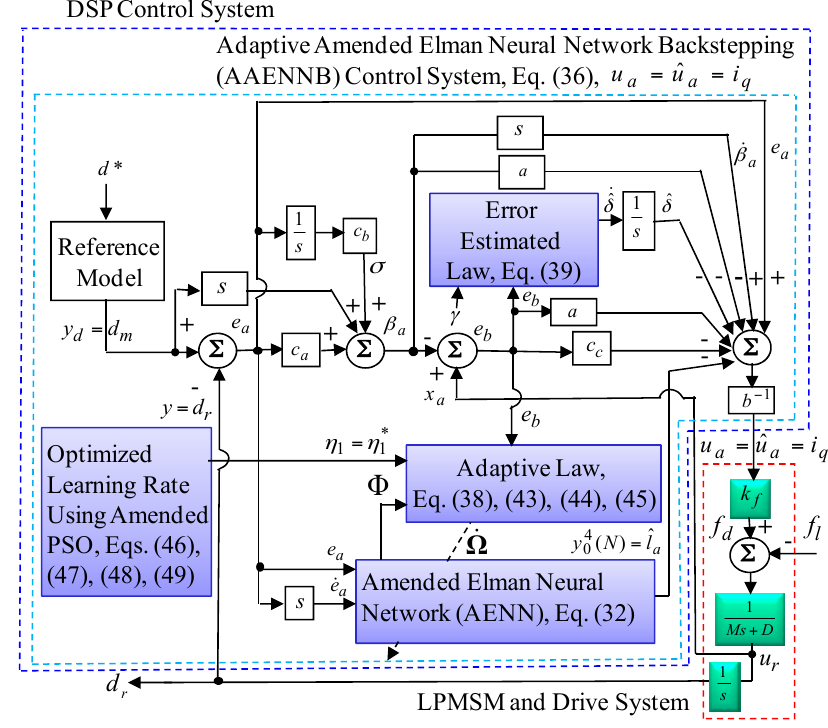
Figure 5. Block diagram of the proposed AAENNB control system using DSP control system.